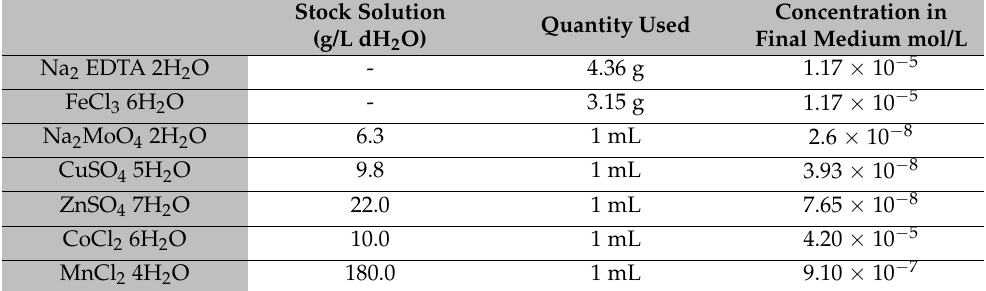
Table 4. Vitamin solution.